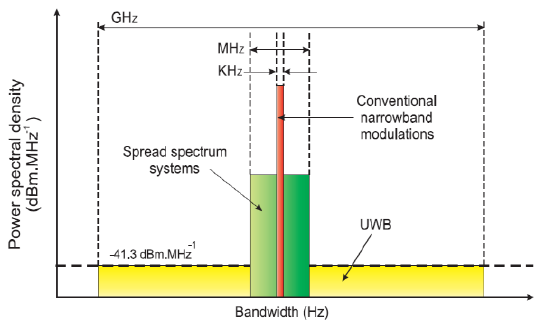
Fig.1. Spectrum allocation of